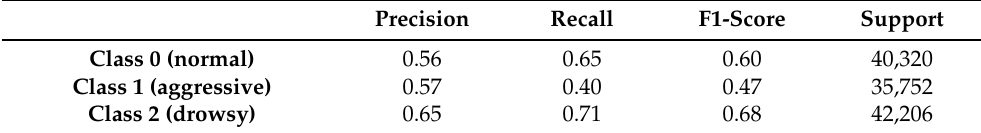
Table 2. Multi-class evaluation metrics with gradient boosting classifier for lane detection.